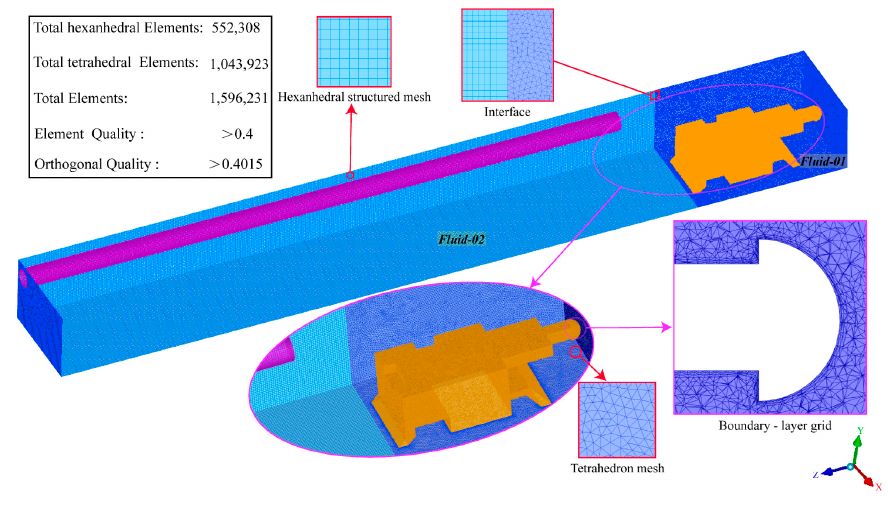
Figure 3. Mesh Figure 3. Mesh model.